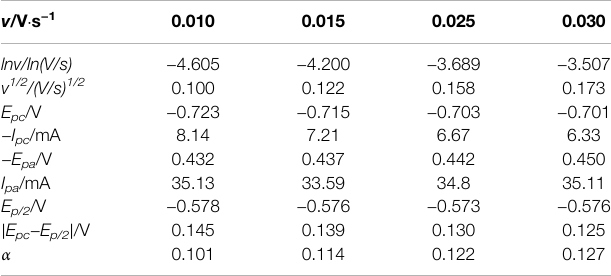
TABLE 2 | Parameters corresponding to cyclic voltammetry curve of In 3+ on Ti electrode at 298